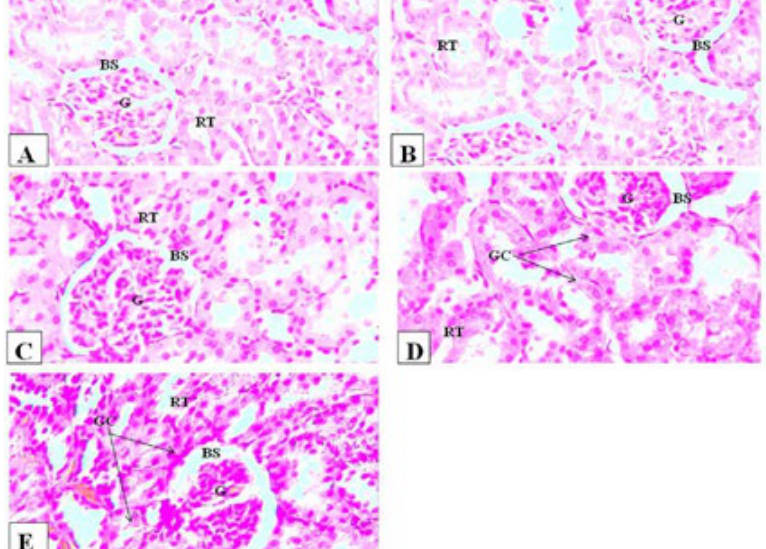
FIGURE 3 - 91 st day kidney sections photomicrographs showing; Plate A (Control), Plate B (62.5 mg/kg), Plate C (125 mg/kg), Plate D (250 mg/kg), Plate E (500 mg/kg). G: Glomeruli, BS: B owman’s space, RT: Renal tubule. GC: Glomeruli congestion.